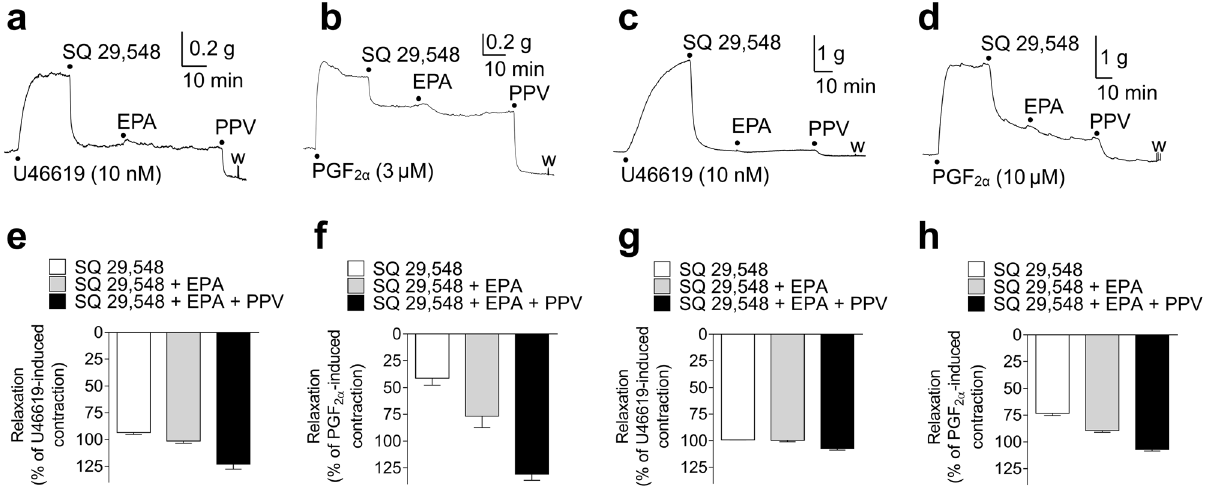
Figure 4. Representative traces showing relaxant responses to 1 μM SQ 29,548 and 30 μM eicosapentaenoic acid (EPA) on porcine basilar ( a , b ) and coronary ( c , d ) artery tonic contractions induced by 10 nM U46619 ( a , c ) and 3 μM/10 μM prostaglandin (PG) F 2α ( b / d ); quantified data of relaxant responses to 1 μM SQ 29,548 and 30 μM EPA on porcine basilar ( e , f ) and coronary ( g , h ) artery tonic contractions induced by 10–30 nM U46619